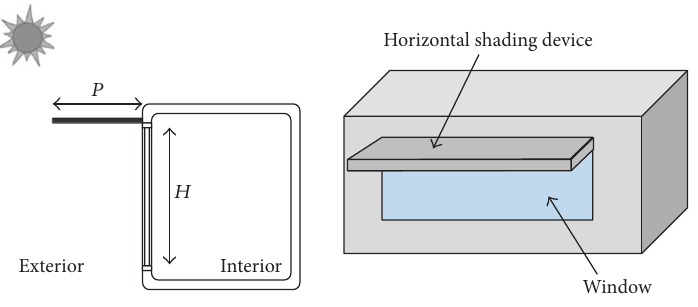
Figure 1: Concept of horizontal